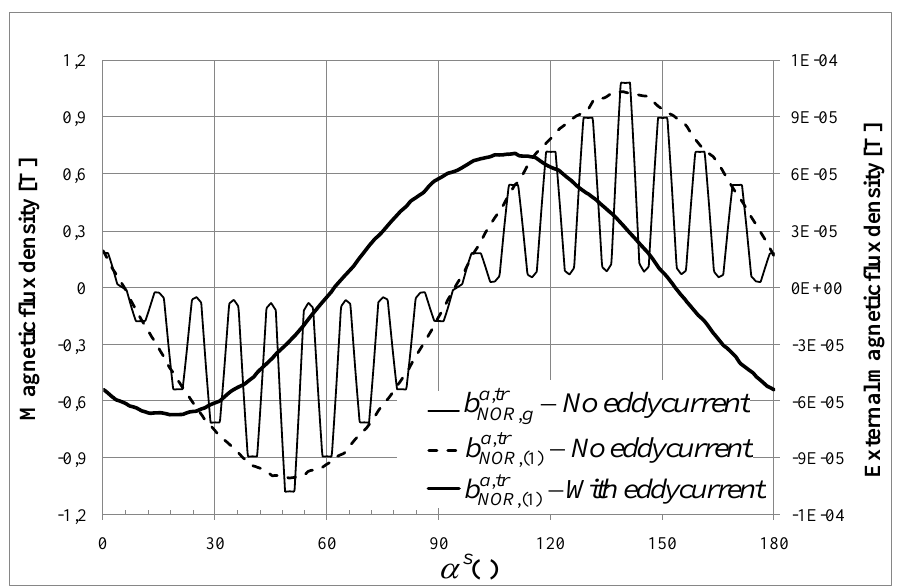
Figure 17. Influence of the eddy currents in the yoke on the normal external